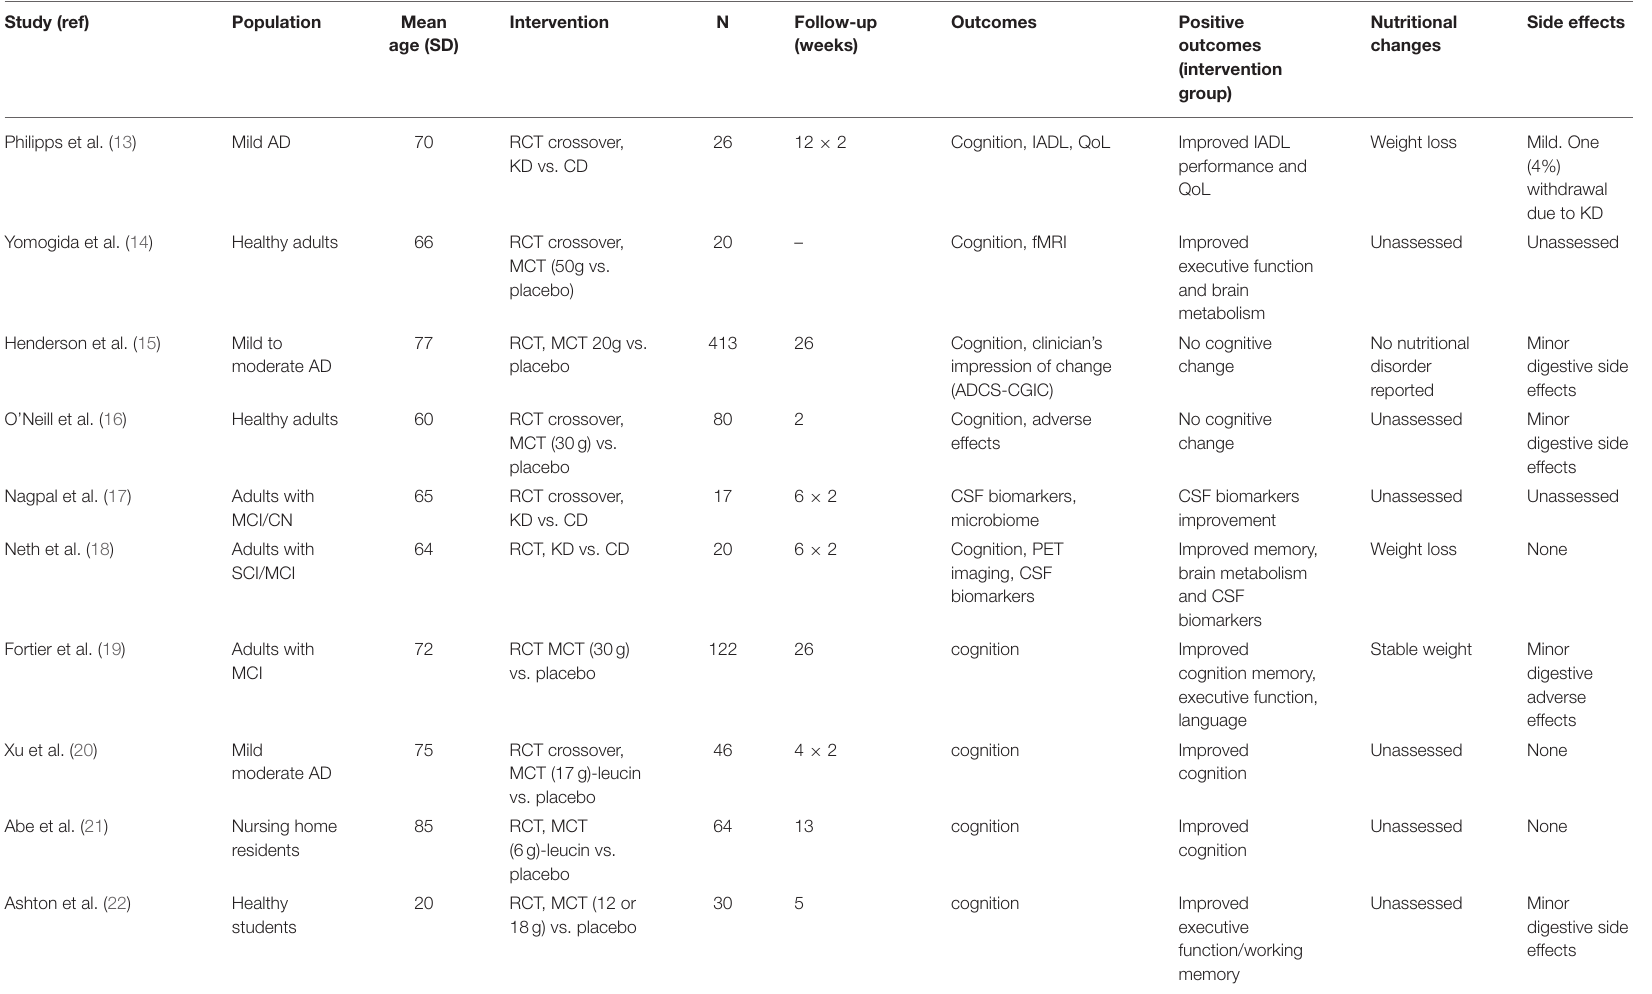
TABLE 1 | Studies of ketone supplementation or ketogenic diet with regards to cognition or AD biomarkers. Study